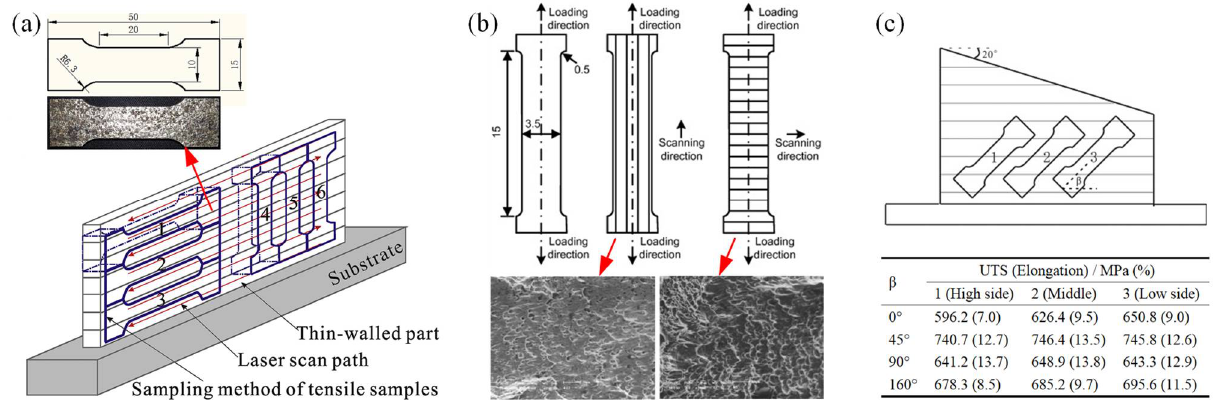
Figure 9. ( a ) Schematic for tensile test specimens of 316L thin-wall. (Reprinted from ref. [37], copyright (2016), with permission from Elsevier); ( b ) Schematic for tensile test specimens SEM morphology of tensile fracture surface of 316 thin-wall (Reprinted from ref. [14], copyright (2013), with permission from Elsevier). ( c ) Schematic for tensile test specimens of 316L slope thin-wall (Reprinted from ref. [2], copyright (2016), with permission from Elsevier).